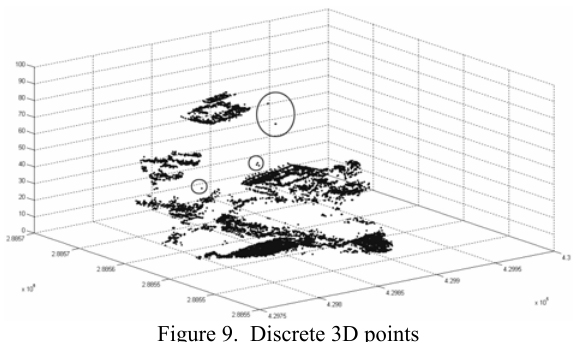
Figure 9. Discrete 3D points